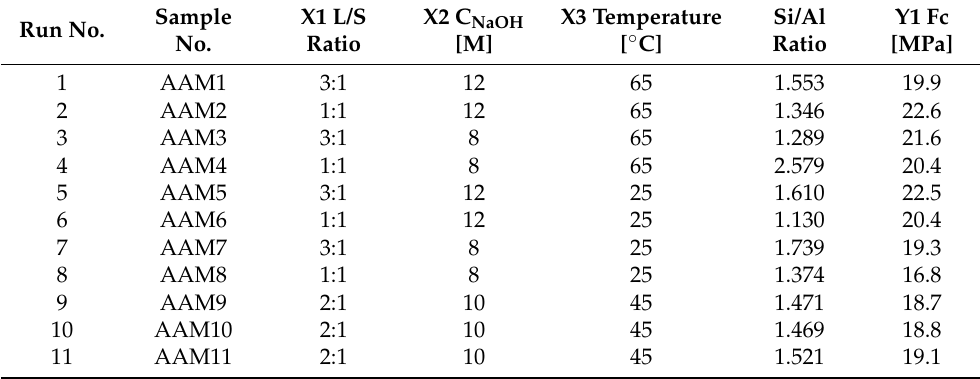
Table 4. The experimental matrix design based on 2 3 factorial methodology. Run